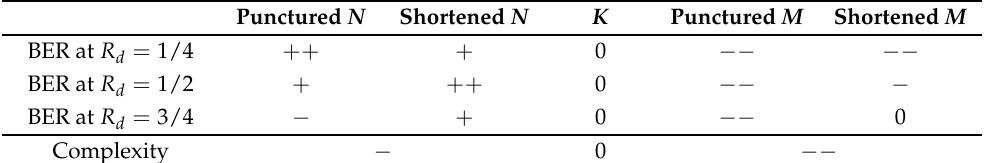
Table 6. Tabulated observations from Scenario